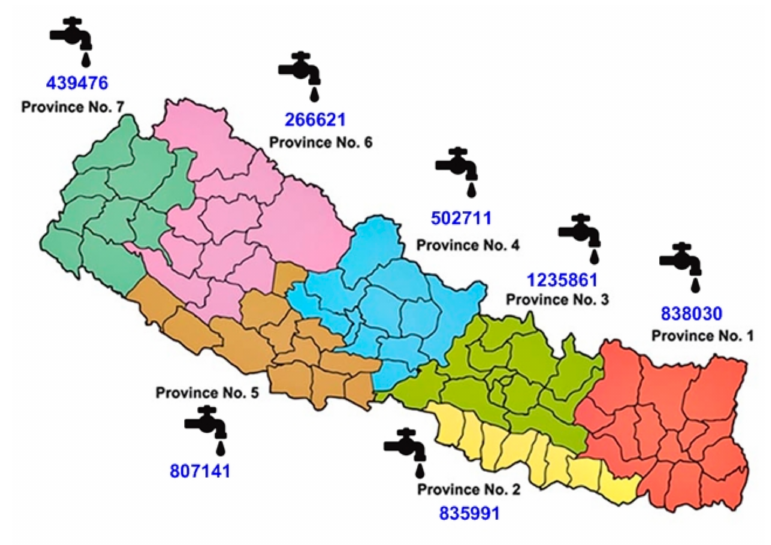
Figure 6. The total number of water supplies based on provinces in